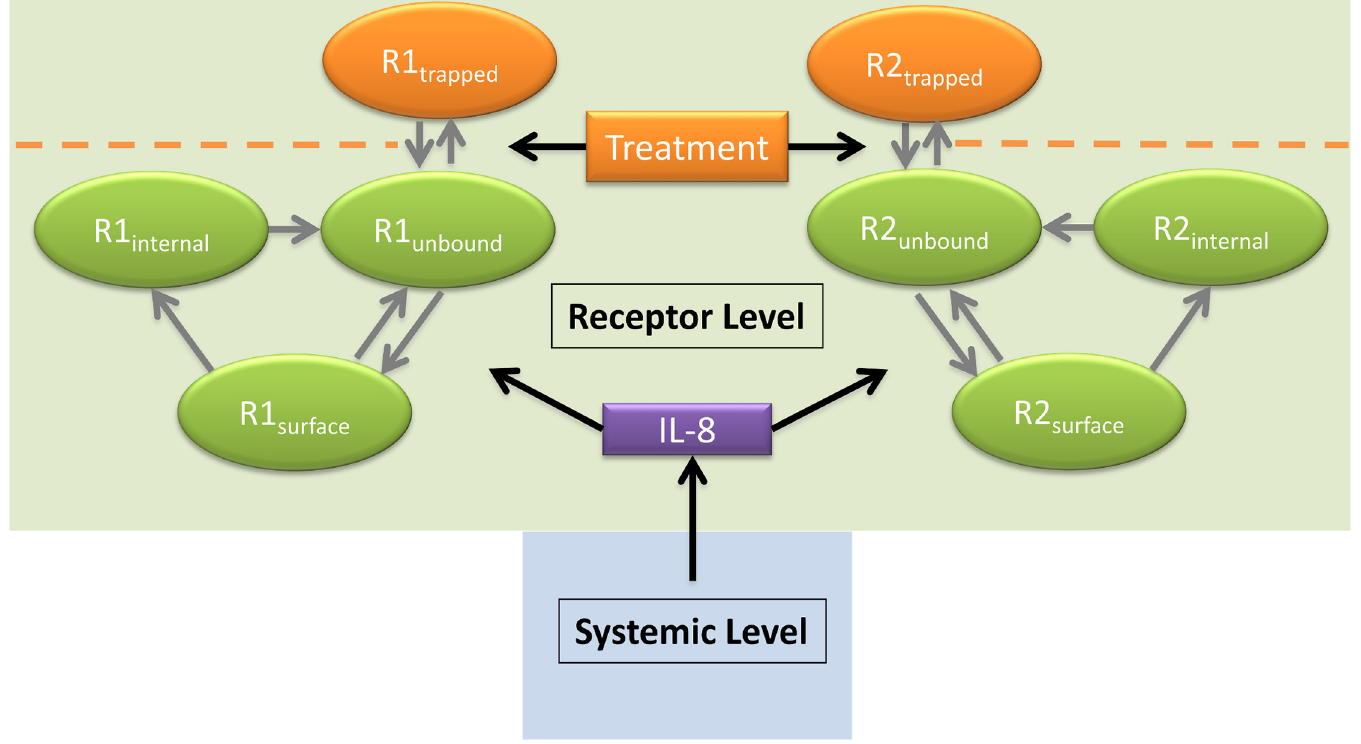
Fig 7. Model diagram showing receptor level treatment implementation. The extracorporeal treatment introduces a trapped receptor state for CXCR-1/ 2. This state prevents IL-8 induced phenotype transition, which limits N K generation. The treatment is modeled entirely in the receptor level of model, leaving the systemic level (see Fig 1)